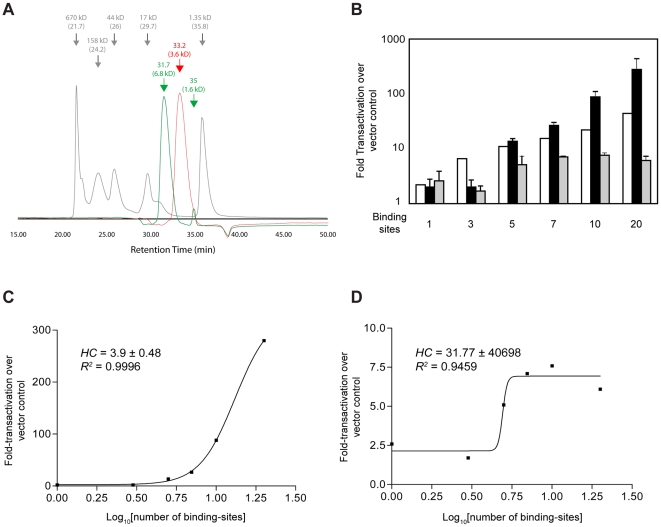
UR1-mediated self-interaction is required for EBNA1 to transactivate cooperatively.(A) Size-exclusion chromatography of the wild-type UR1 peptide indicates zinc-dependent dimerization. WT peptide was subjected to HPLC size-exclusion chromatography, as described in the Methods section, in the absence of zinc (red), or in the presence of 1 mM zinc sulfate in the buffer (green). The retention time is indicated above each peak, and the apparent molecular weight calculated from the retention time is shown in parentheses. The elution profile of molecular weight markers is shown in gray. The known molecular weight of each marker is indicated above the peak, with the observed retention time shown in parentheses. (B) Cooperative transactivation by EBNA1 is UR1-dependent. C33a cells were co-transfected individually with TKp-luciferase reporter plasmids containing one, three, five, seven, ten, or 20 EBNA1 binding sites in FR along with an expression plasmid for EBNA1 or EBNA1(CC→SS). Cells were harvested at 48 hours post-transfection, normalized by flow cytometry for the number of live-transfected cells, and analyzed for luciferase activity, which is expressed as luciferase activity fold-over the activity obtained by co-transfection with vector control. The white bars indicate the predicted levels of transactivation for EBNA1 if it increased additively with increasing numbers of binding sites. The transactivation observed with EBNA1 is indicated by the black bars, and transactivation observed with EBNA1(CC→SS) is indicated by the gray bars. For reporter plasmids containing up to three binding sites, EBNA1 and EBNA1(CC→SS) transactivated equivalently. A small difference was observed for a reporter plasmid with five binding sites, and this difference was greatly accentuated for reporter plasmids containing seven, ten, and 20 binding sites. (C) Cooperative transactivation by EBNA1 fits a sigmoidal dose-response model by non-linear regression analysis. The fold transactivation by EBNA1 observed in (5B) was analyzed for cooperativity as described in the Materials & Methods, and found to fit a sigmoidal dose-response model well, as indicated by the goodness of fit (R2). Positive-cooperativity is inferred from the positive Hill coefficient (HC). (D) EBNA1(CC→SS) does not activate transcription cooperatively. The fold transactivation observed for EBNA1(CC→SS) was fit to the same sigmoidal dose-response model used in 5C. The low R2 indicates that transactivation by EBNA1(CC→SS) poorly fits this model. In addition, the large standard deviation observed for the HC also indicates a lack of cooperative transactivation.